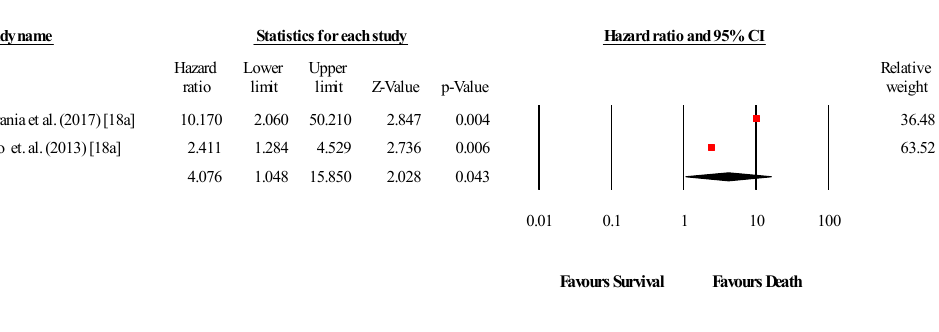
Figure 7. Forest plot for miR-18a association with OS.